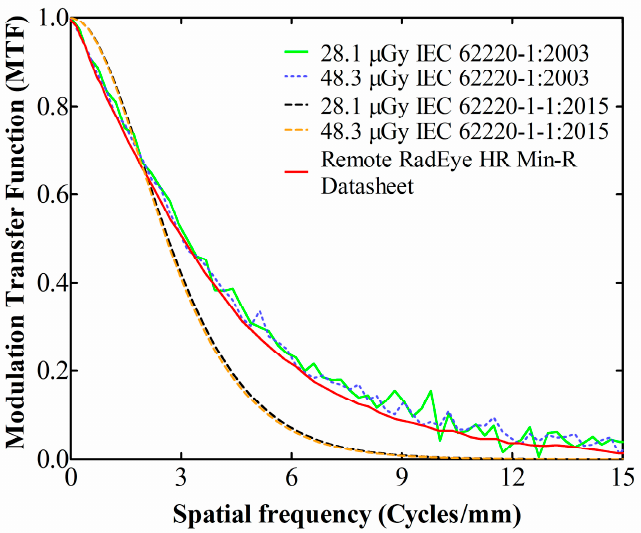
Figure 4. MTF comparison between measured values according to IEC 2003 and IEC 2015, along with manufacturer data